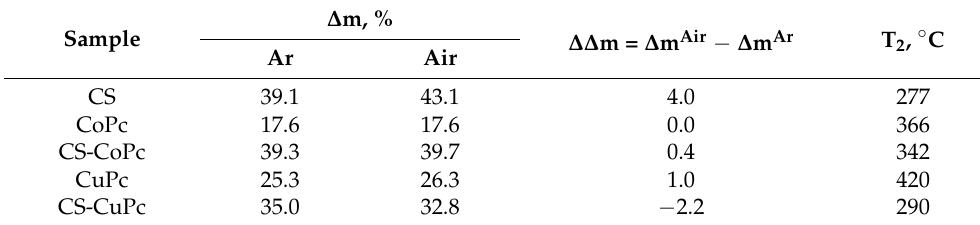
Table 2. The mass loss of samples in the temperature range